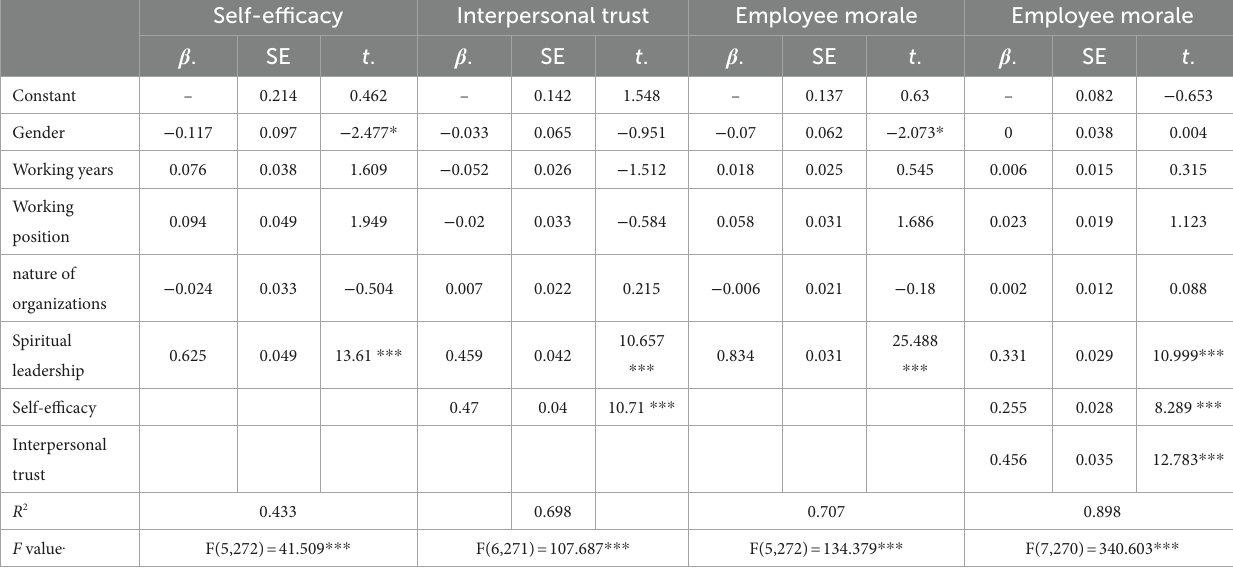
TABLE 4 Test results of intermediary effect model between spiritual leadership and employee